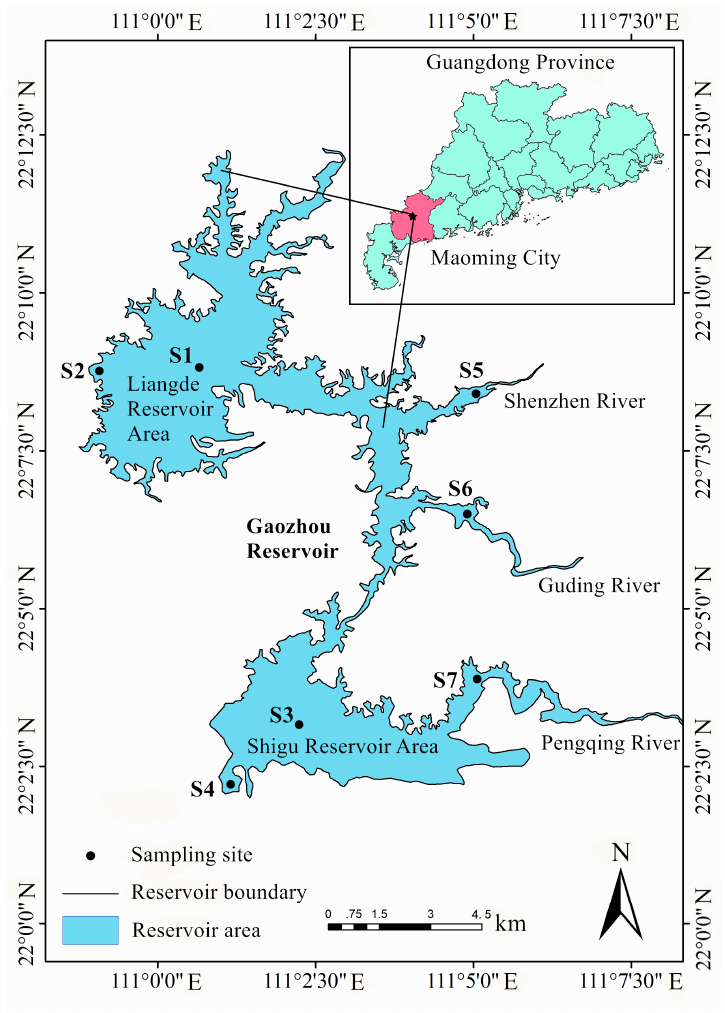
Figure 1. of the Gaozhou Reservoir and of the sampling sites in the reservoir.